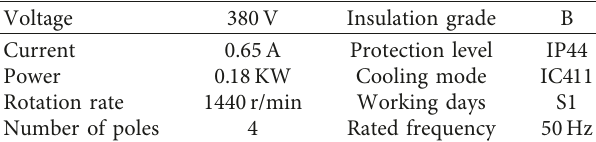
Table 1: JW6314 motor parameters.